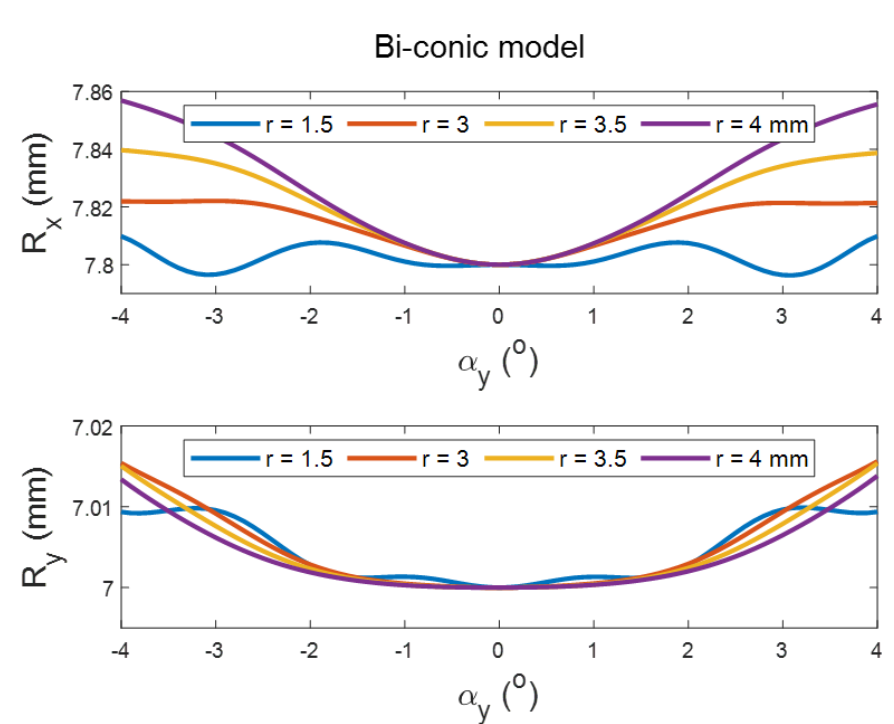
Figure 2. Effect of tilting a simulated conic surface of nominal apical radius of 7.8 mm and nominal asphericity of − 0.2 on its radius and asphericity as fitted in tilted positions at different aperture sizes. Tilt has been introduced by rotating the surface around the Y-axis, then shifting the apex to the origin position.